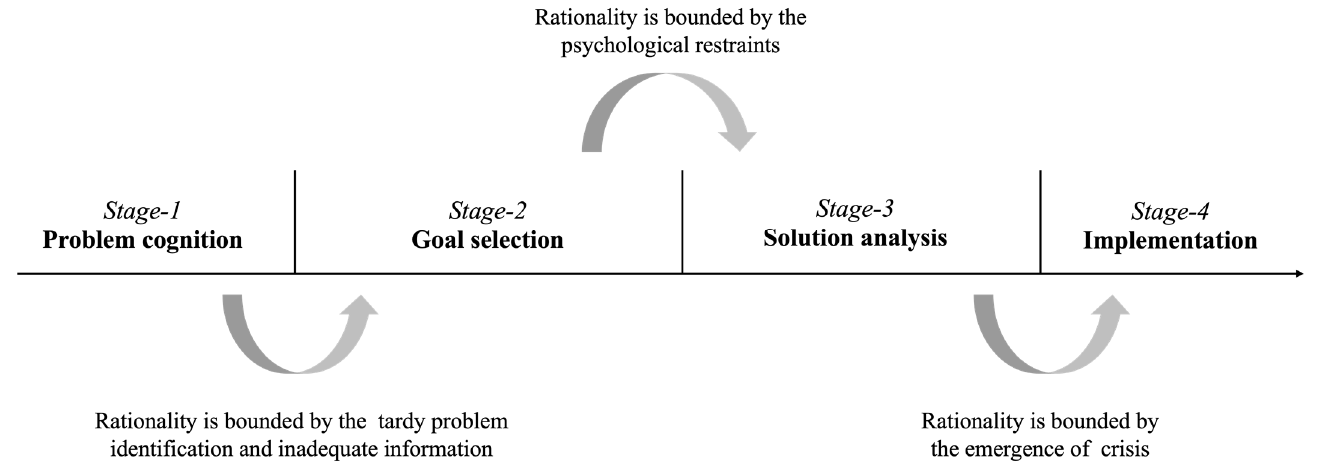
Figure 1. Diagram of the bounded rationality. Flow chart made by authors.